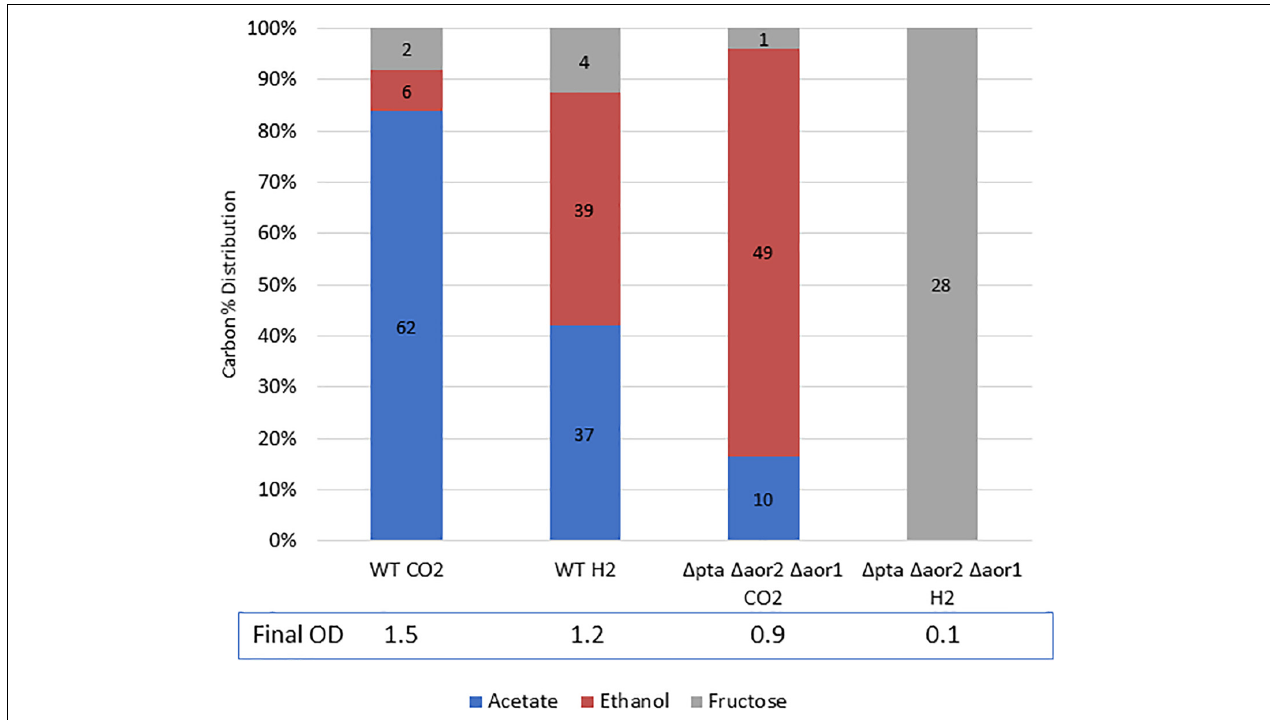
FIGURE 6 | Mixotrophic growth and fermentation products of wild type vs. (cid:49) pta (cid:49) aor2 (cid:49) aor1 on PETC with 5 g/L fructose with either 100% CO 2 or 100% H 2 . Strains were grown on 5 g/L (28 mM) fructose with the indicated headspace gas (CO 2 or H 2 ). Carbon distribution of fermentation products/residual fructose is indicated by bar chart%, while the number label is mM amount after 5 days. The OD 600 after 5 days is indicated at the bottom.